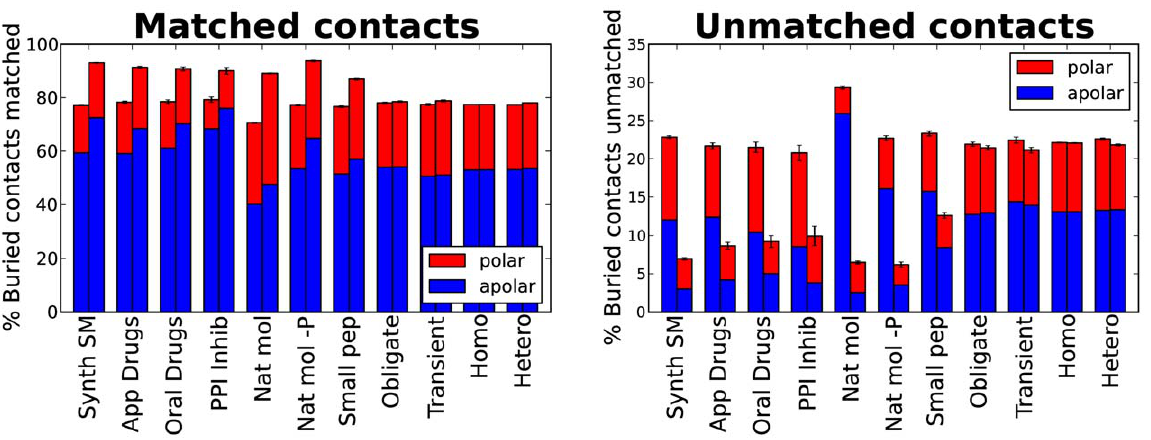
Figure 2. Matched and unmatched contacts. Mean of the percentage of buried atoms per molecule engaged in successful interactions (Matched contacts, left chart) and mean of the percentage of buried atoms without an appropriate partner in the other side of the interface (Unmatched contacts, right chart). The percentage is divided into polar (red) and apolar (blue) contribution. Each set has two bars, one on the left for the atoms in the protein and one on the right for the atoms in the ligand or smaller protein in the case of protein complexes. Error bars denote the standard error of the mean. Sets are ordered from left to right: Synthetic small molecules, approved drugs, oral drugs, protein-protein interaction small molecule inhibitors, natural molecules, natural molecules without phosphor, small peptides, obligate protein-protein dimers, transient protein- protein dimers, homo quaternary protein-protein interfaces and hetero quaternary protein-protein interfaces.